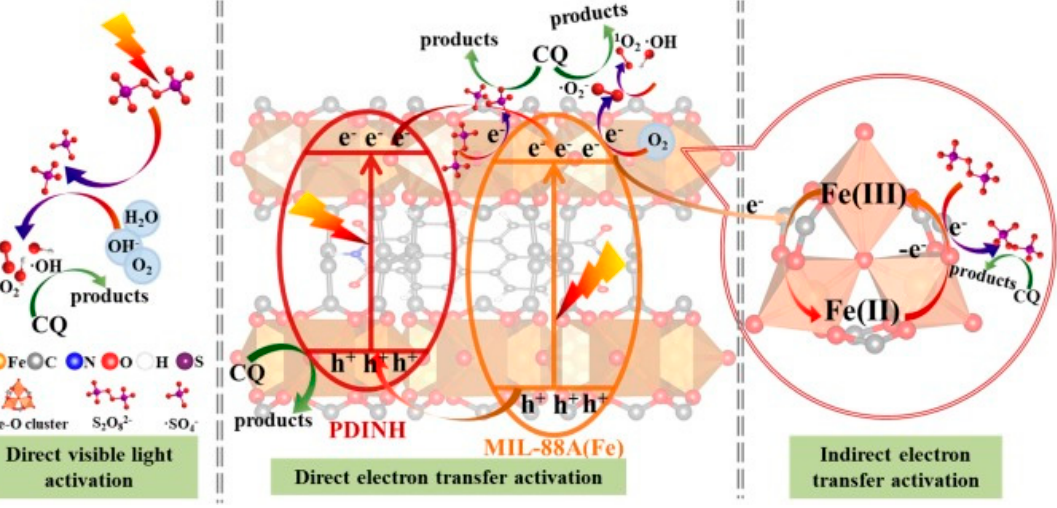
Figure 5. A possible pathway for photocatalysis-activated SR − AOP oxidation of CQ over P25M175 in the presence of LED visible light. Reprinted/adapted with permission from Ref. [114]. Copyright